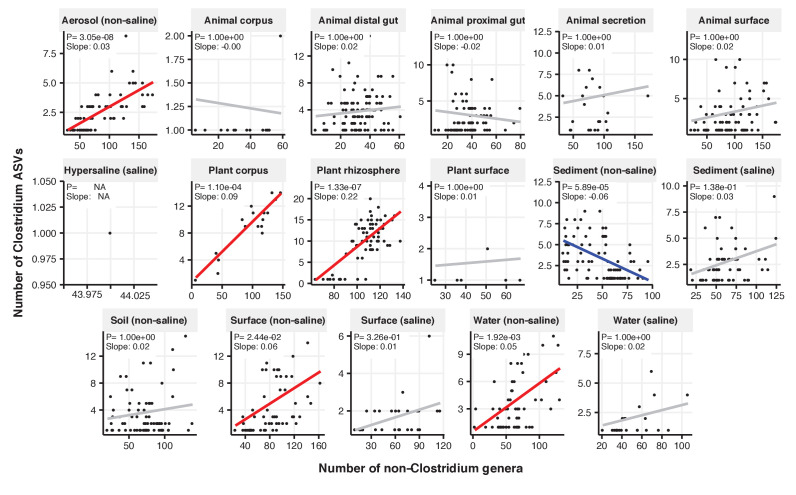
Focal-lineage diversity as a function of community diversity across biomes in Clostridium.Linear models are shown for ASVs per genus (y-axis) as a function of community diversity (non-focal genera, x-axis) in each of the 17 environments (EMPO3 biomes). Only environments containing the focal lineage are shown. Significant positive diversity slopes are shown in red, negative in blue (linear models, p<0.05, Bonferroni corrected for 17 tests), and non-significant in grey.